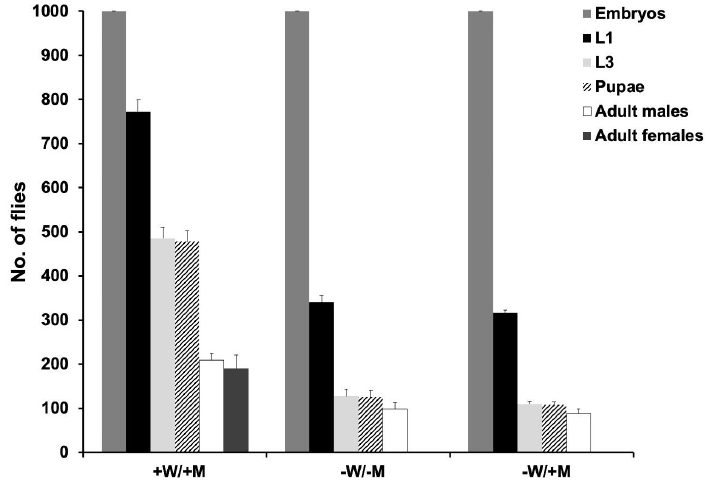
Figure 3. Female-specific lethality of TESS. The DR2#7; EF3A ( a ) and DR2#8; EF3A ( b ) strains were raised under different tetracycline feeding regimens. Containers were set with 10 pairs of adults and the number of third instar larvae (L3), pupae and adult male and female offspring counted. +W: water with 100 μg/mL tetracycline from day 1 (D1) to D8; + −W: water with limited tetracycline at indicated concentration from D1 to D2, then switched to water without tetracycline from D3 to D8; +M: ground meat (larval diet) with 100 μg/g tetracycline; −M: meat without tetracycline. Mean and standard error are shown from three replicate experiments.